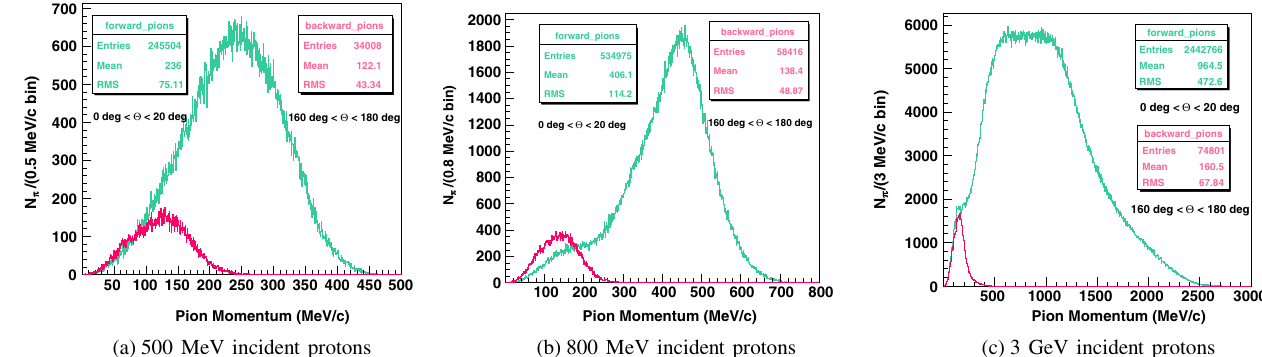
FIG. 10. Pion momentum distributions at various incident proton energies.